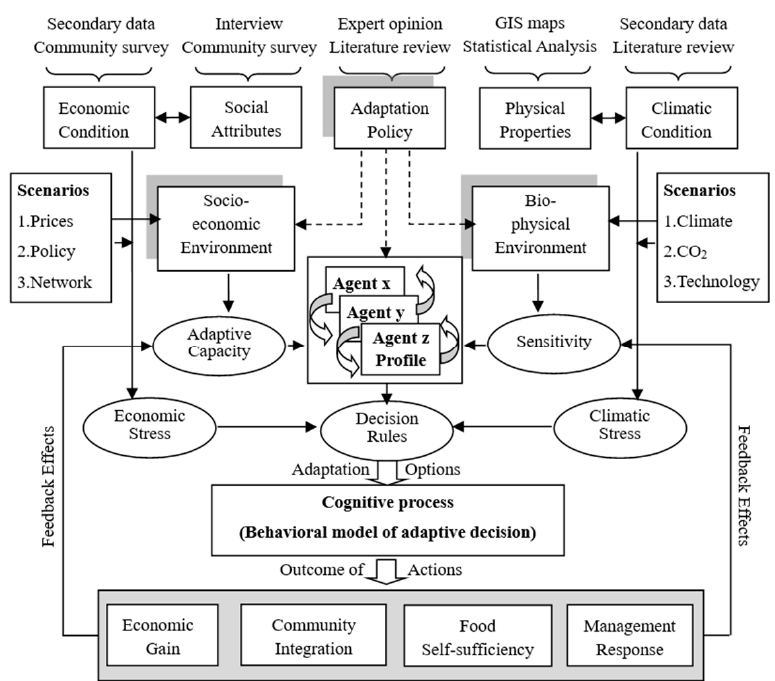
Figure 3. An agent-based inter-vulnerability framework to assess vulnerabilities and adaptations.